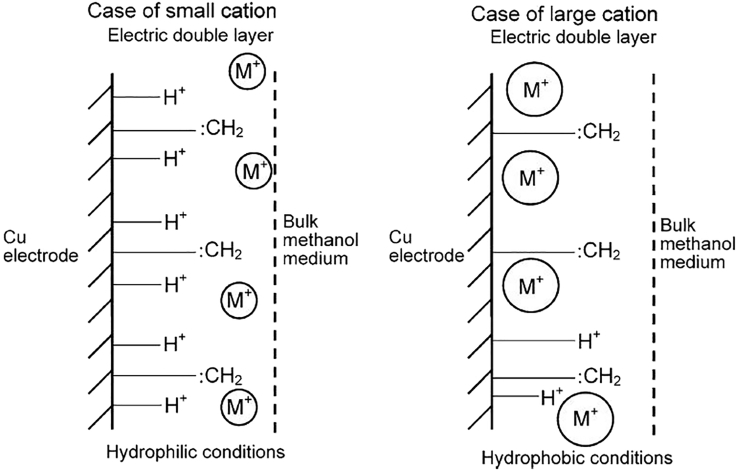
Schematic of Hydrophilic (Protons, Small Cations) and Hydrophobic (Large Cations) WE Environment in the CO2RR at CuReproduced with permission from (Kaneco et al., 2006a, Kaneco et al., 2006b, Kaneco et al., 2006c).